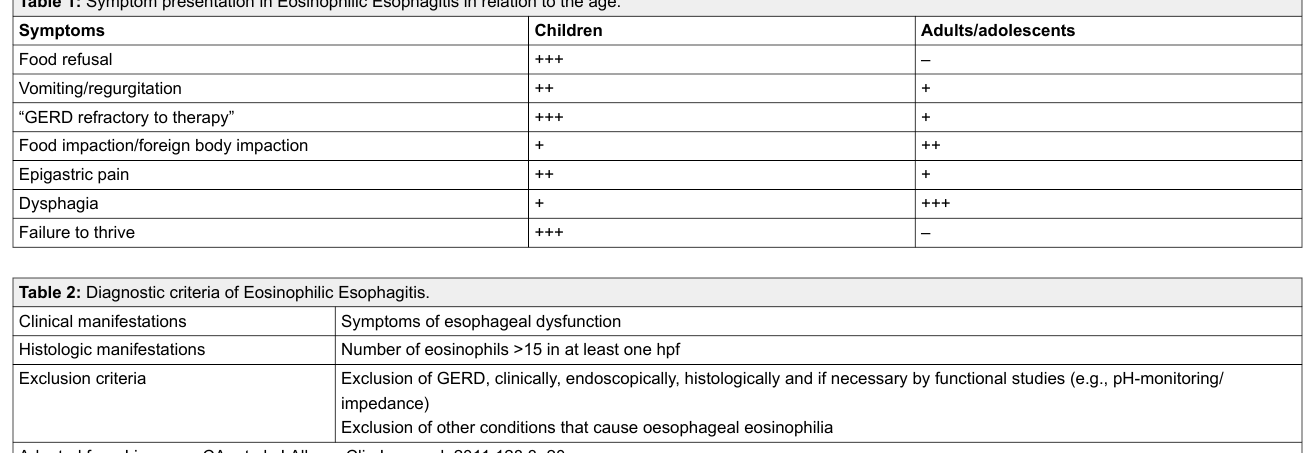
Table 1: Symptom presentation in Eosinophilic Esophagitis in relation to the age. Symptoms Children